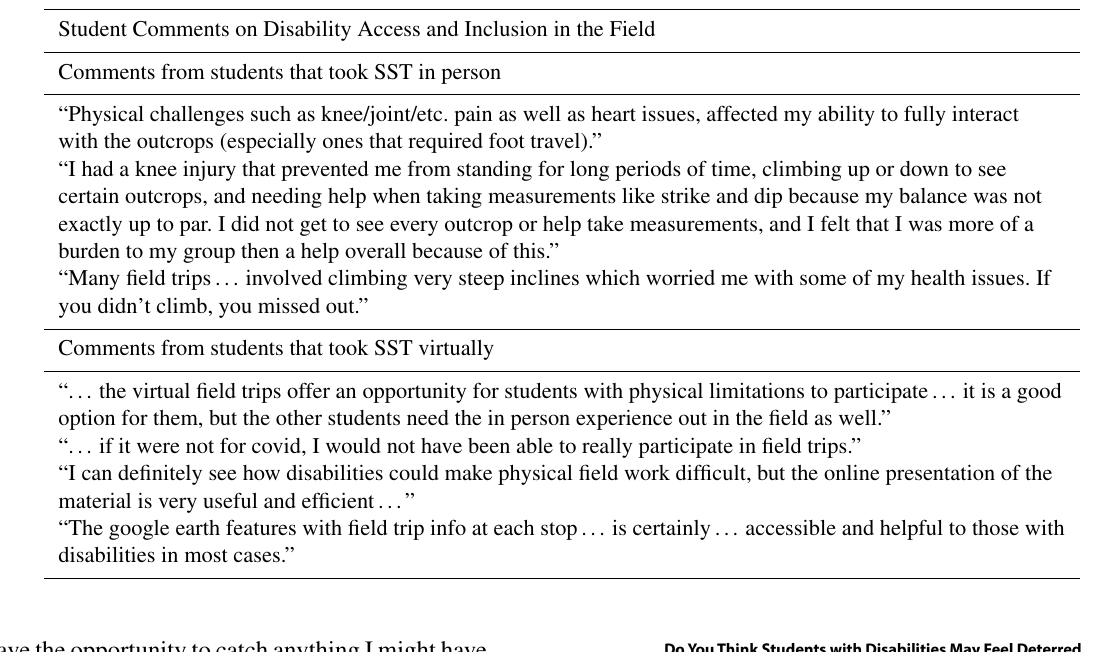
Table 1. Responses from the student survey that discuss disability access and inclusion issues for field trips. Responses are grouped according to modality of learning environment (in-person or virtual.)